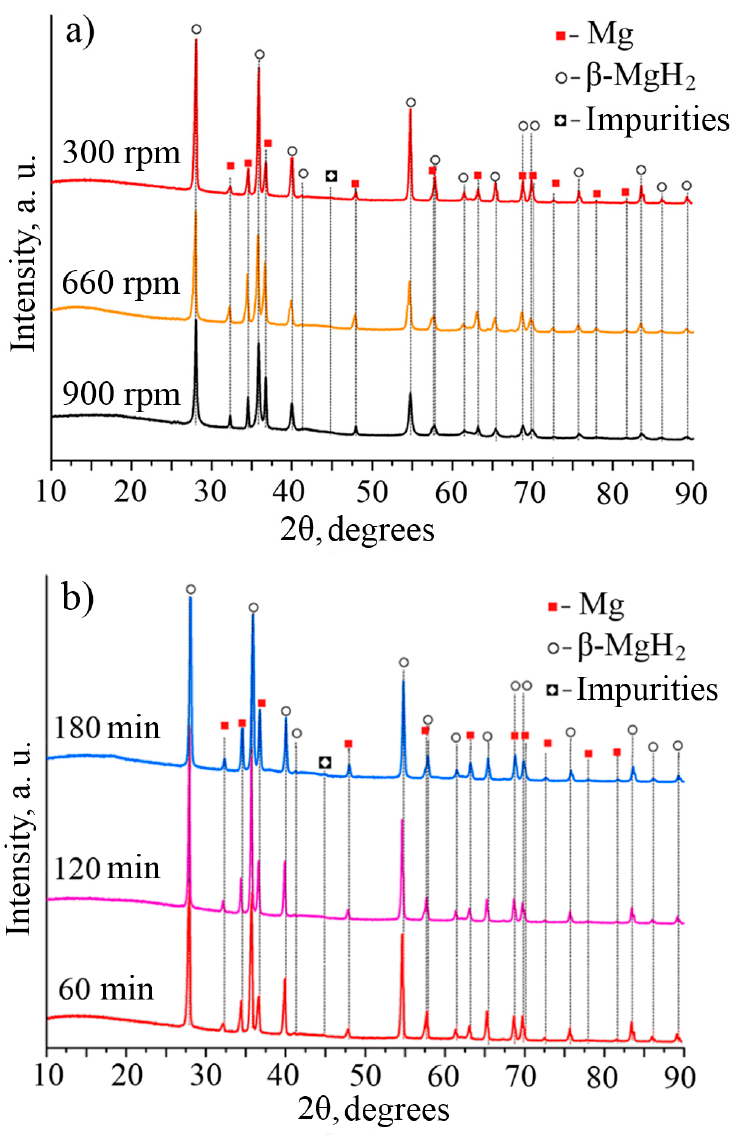
Figure 7 represents a comparison of X-ray diffraction patterns for MgH 2 –5 wt.% SWCNT composites with respect to speed with a grinding time of 60 min (Figure 7a) and with milling at a speed of 300 rpm (Figure 7b).